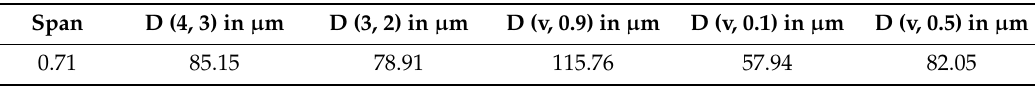
Table 5. Results of Hall flow test [13].